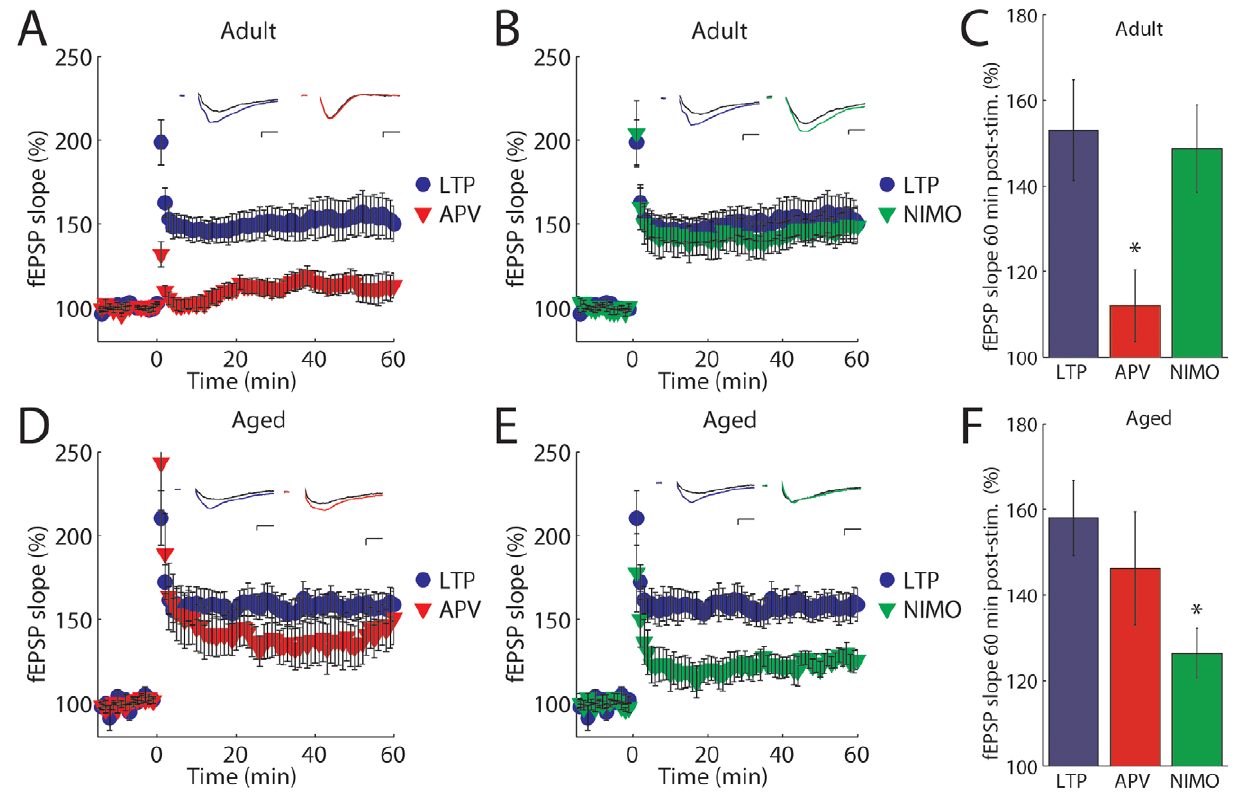
Figure 1. LTP is NMDAR-dependent in adult mice but L-type calcium channel-dependent in aged mice. ( A and B ) CA1 fEPSP slope in adult mice in control conditions (blue N , n=14) and with APV (50 m M) (red . , n=11) or nimodipine (10 m M) (green . , n=8) in response to HFS applied at t=0. Inset, averaged fEPSP traces. ( C ) Summary data:in adult, LTP is blocked by APV ( P =0.01) but not by nimodipine ( P =0.81). ( D and E ) fEPSP slope in aged mice in control (blue N , n=7) and with APV (red . , n=8) or with nimodipine (green . , n=6) in response to HFS. Inset, averaged fEPSP traces. ( F ) Summary data: in contrast to adult, LTP in aged mice is blocked by nimodipine ( P =0.01) but not by APV ( P =0.48). Scale bars: 10 ms, 0.4 mV. All data are expressed as mean 6